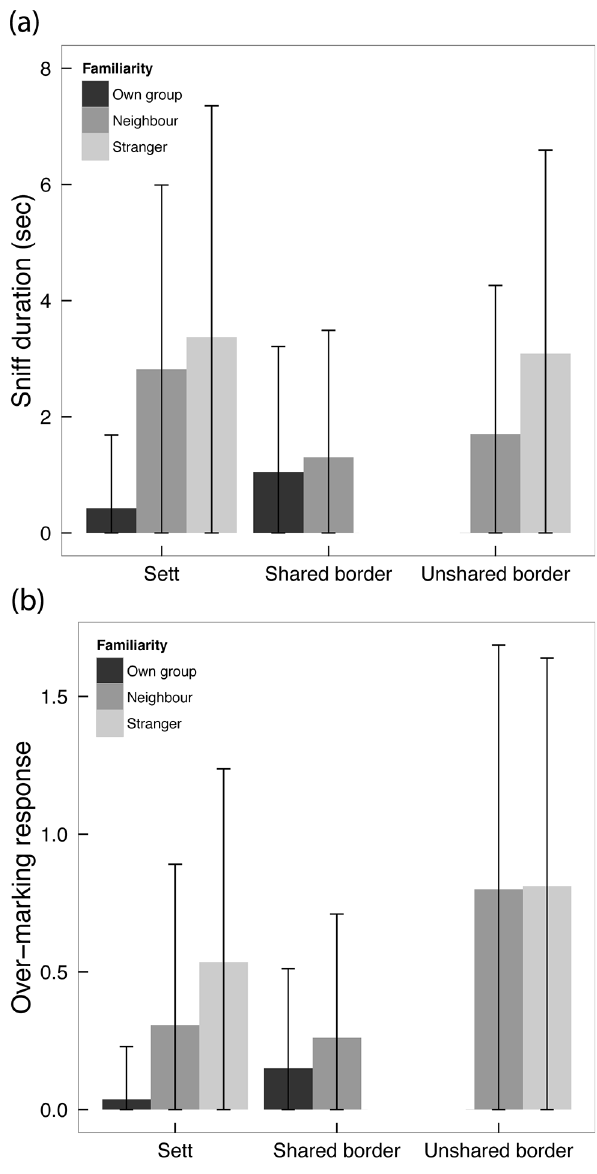
potential response to AGS from own – group ( n = 20 trials), neighbours ( n = 35) and strangers ( n = 30) presented at either the responder ’ s sett, or a border (shared or unshared) between the responder and the scent